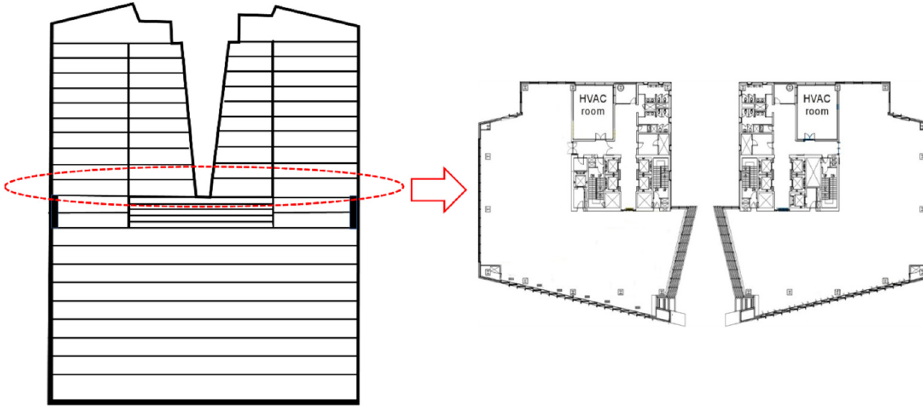
Figure 2. The main façade of the office building.